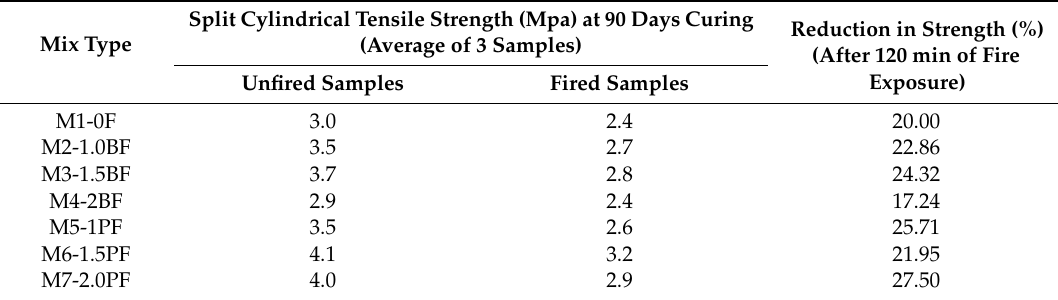
Figure 13. Effects of 120 min of fire exposure on the split cylindrical tensile strength. Figure 13. E ff ects of 120 min of fire exposure on the split cylindrical tensile strength. Table 4. Reduction in split cylindrical tensile Table 4. Reduction in split cylindrical tensile strength.